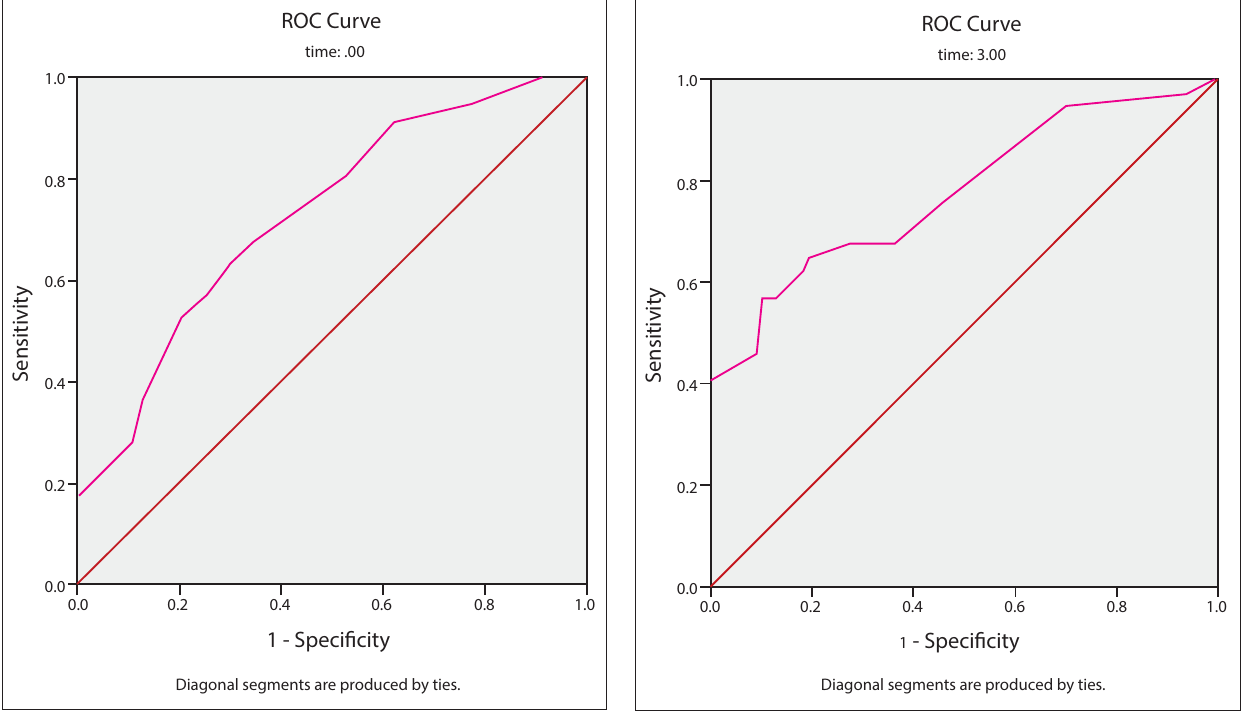
Fig. 1. ROC curve of SRSS scores for suicidal ideation immediately post- diagnosis (baseline) in HIV-infected adults.